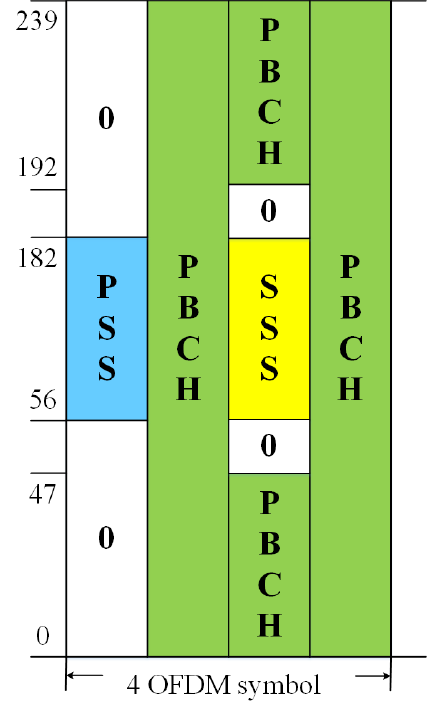
Figure 3. SS/PBCH resource